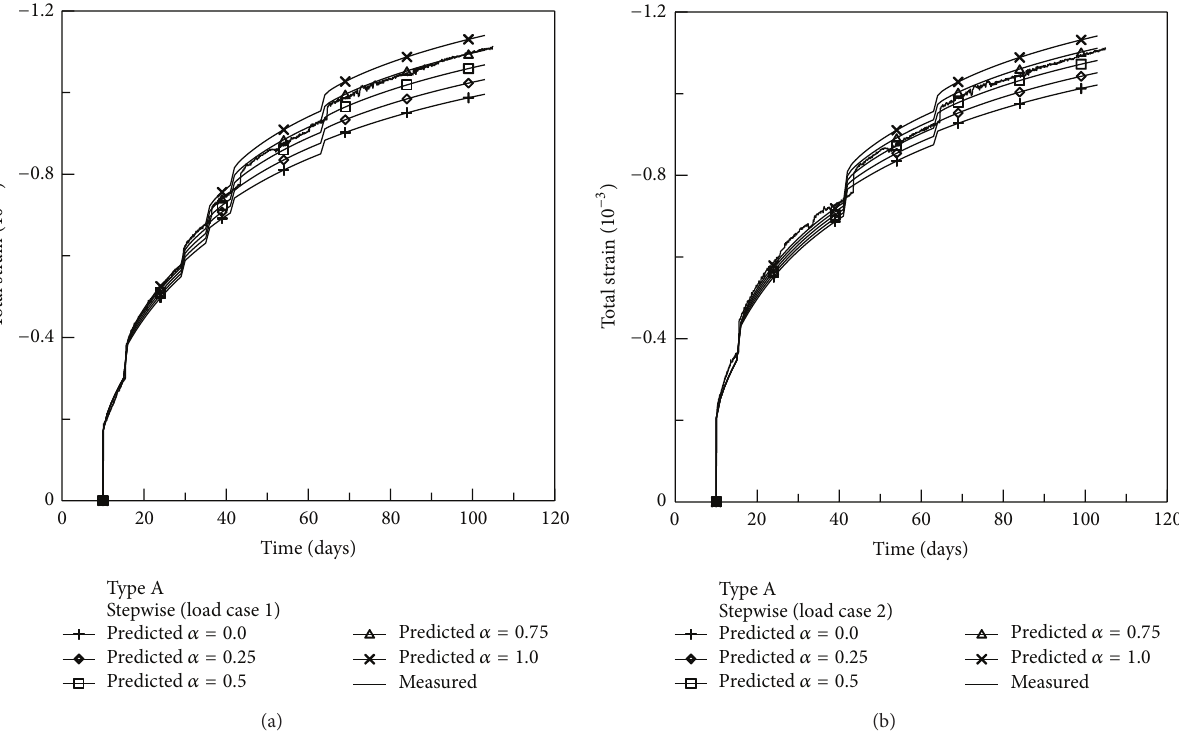
Figure 6: Predicted and measured total strains for the two stepwise load cases of type A test: (a) load case 1 and (b) load case